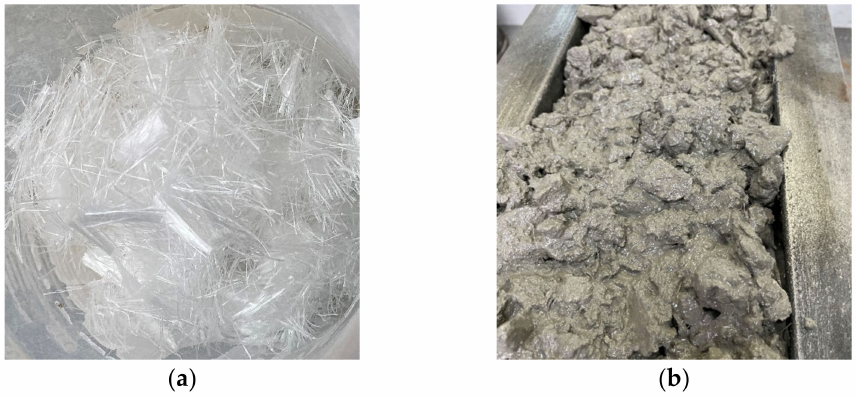
Figure 2. Polypropylene fibers ( a ) as received; ( b ) during mixing.